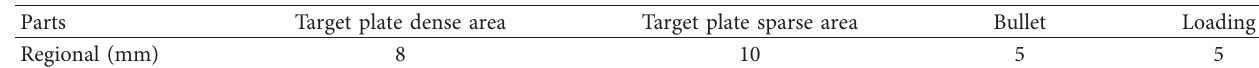
Figure 2: Reinforcing rib plate and missile’s finite element model. Table 1: Unit size of each